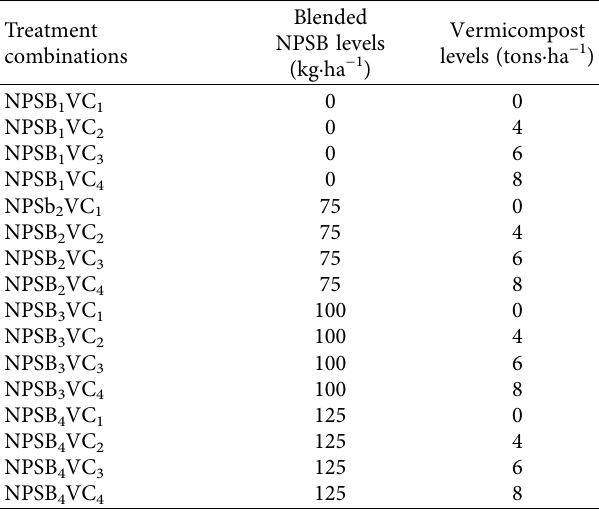
Table 2: Description of the various treatment